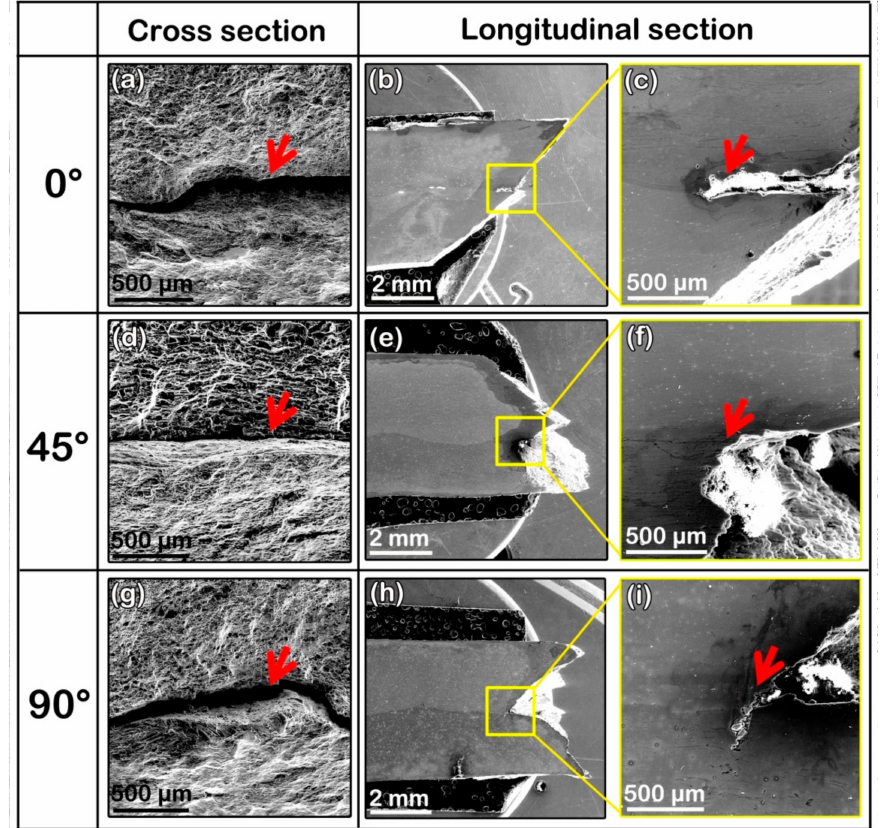
Figure 9. SEM images showing cross ( a , d , g ) and longitudinal ( b , e , h ) sections of fracture samples (for W3/L5 laminated composite) applied to tension along 0 ◦ , 45 ◦ and 90 ◦ , respectively; ( c , f , i ) views of high magnification from yellow frames in ( b , e , h ), respectively. Table 3. Deviations of applied stresses between W3 and L5 layers at the serration strain on each stress-strain curve of the W3/L5 laminated composite along 0 ◦ , 45 ◦ and 90 ◦ at RT. Tensile